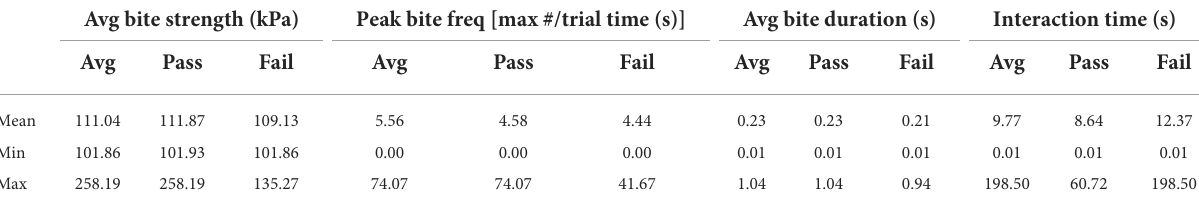
TABLE 4 Mean, min, and max values for each independent feature for the ball-human condition (feature average and by outcome; does not include trials with zero